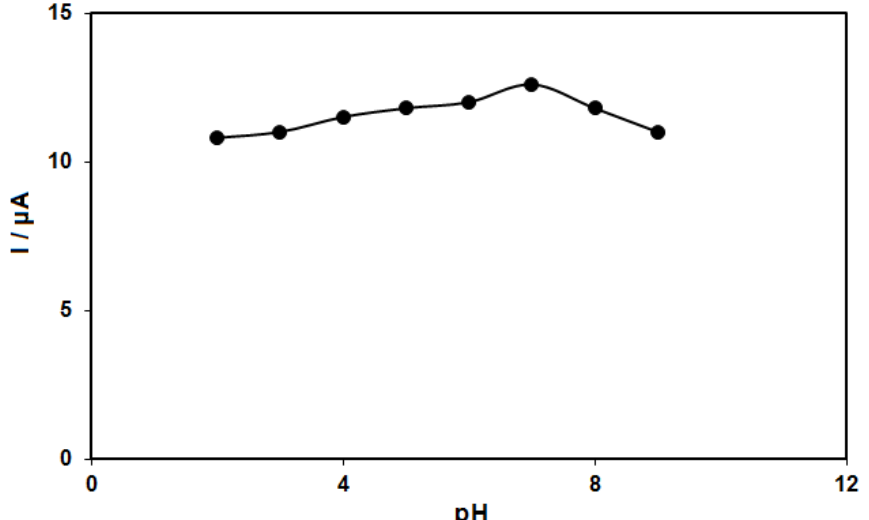
Figure 5. Plot of Ip vs. pH obtained from DPVs of NiCo-MOF/SPGE in a solution containing 100.0 µM of epinine in 0.1 M PBS with different pHs (2.0, 3.0, 4.0, 5.0, 6.0, 7.0, 8.0 and 9.0).